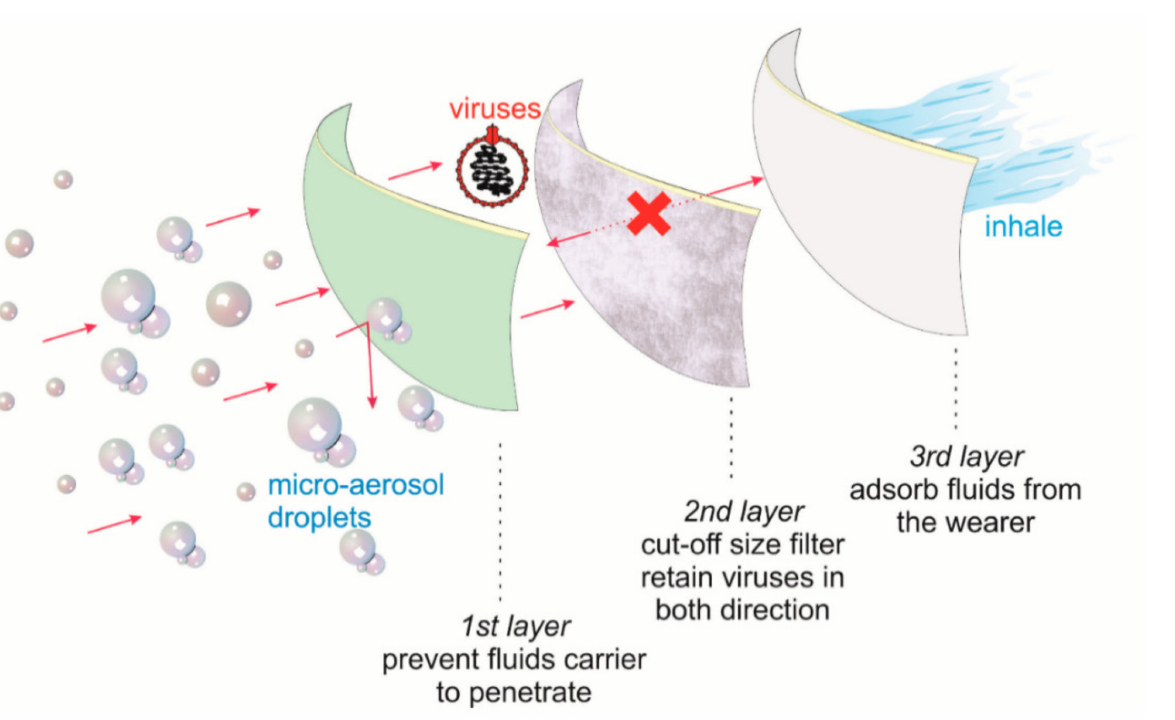
Figure 3. Structure of the surgical face mask (adapted with permission from Reference